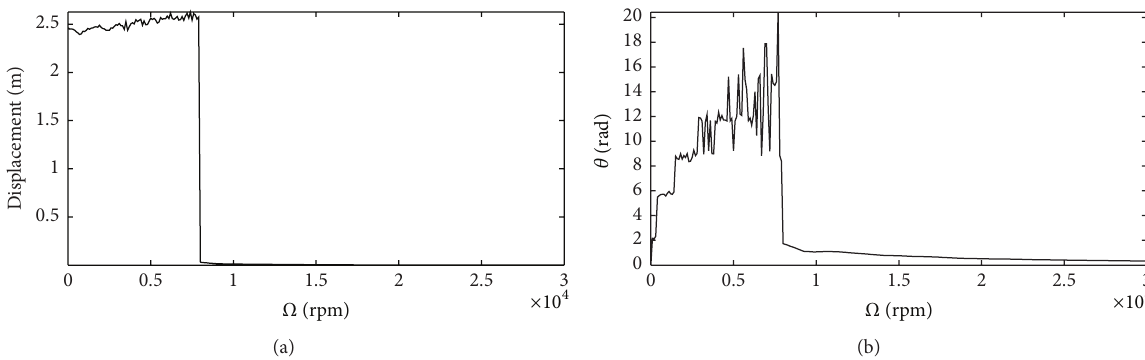
Figure 7: Rotational speed response curves: tip response of beam (a); gyro response (b) for 𝑘 = 𝐼 𝑜 𝜔 2 𝑛 /2 = 6.4 Nm / rad and 𝑐 opt = 𝐼 𝑜 𝜔 2 𝑛 /4𝜔 𝑔 = 0.9 Nms / rad with the base excitation of 𝑧 = 0.05 cos (𝜔